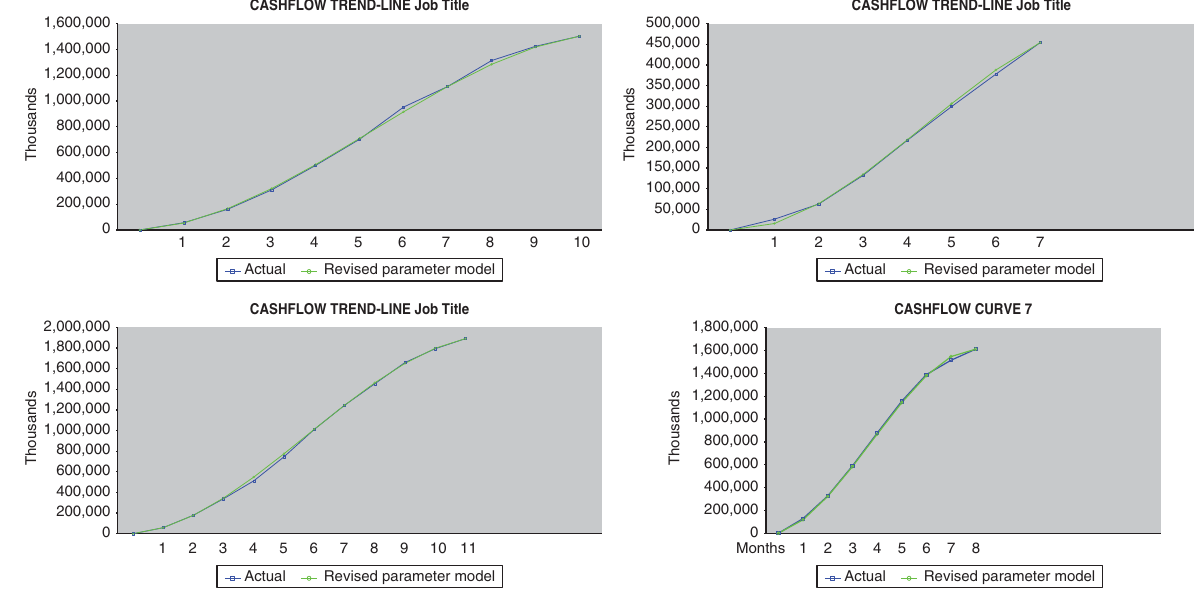
Fig. 8. Cash fl ow curves (for project 91, incorporating the proposed parameter values for steel frame; for project 98, incorporating the proposed parameter values for refurbishment; for project 92, incorporating the proposed parameter values for new build; for project 7, incorporating the proposed parameter values for design and